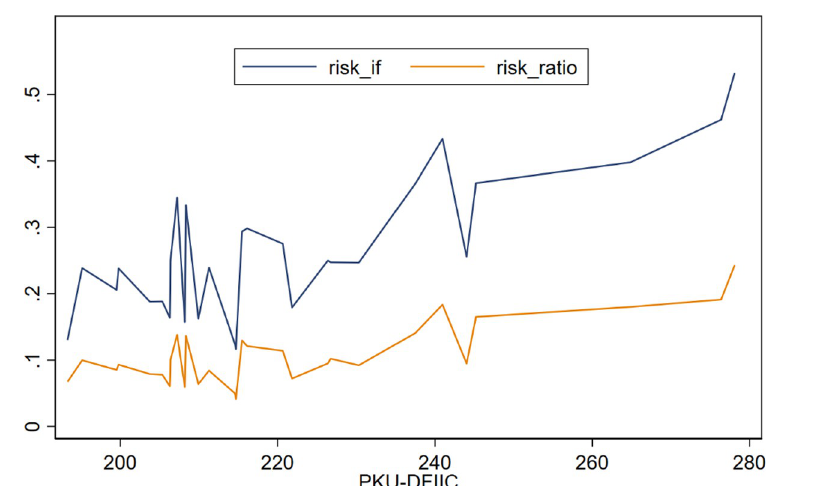
Fig 2. Distribution of digital finance and household participation.